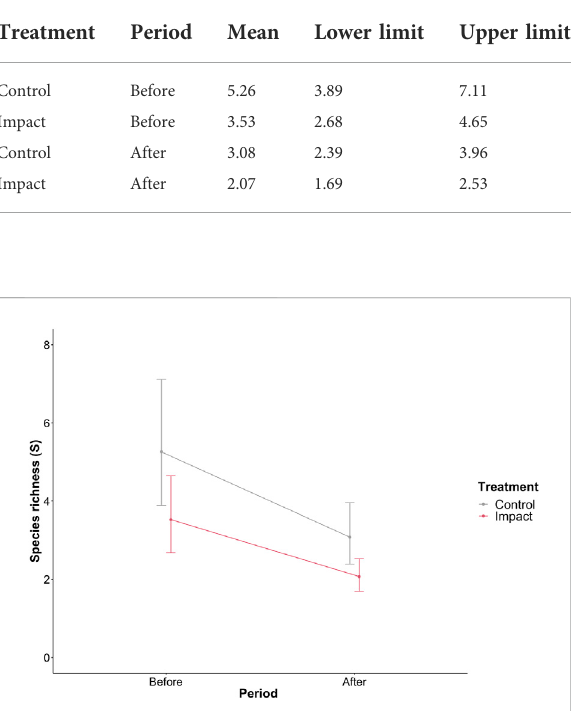
FIGURE 6 Least square means values of species richness before and after DFWAR project. Error bars show the ± CI from the glmer